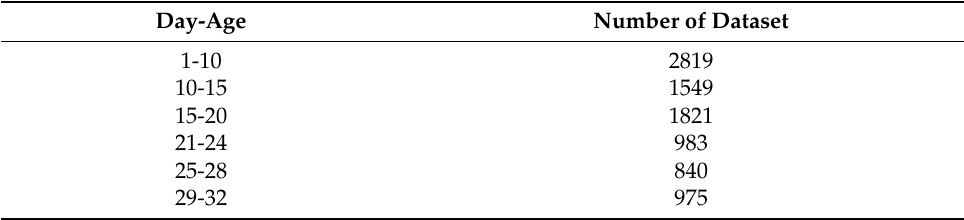
Figure 2. Illustration of dataset, ( A )–( F ) are images of chickens at different day-ages. Table 2. Distribution of different day-age data